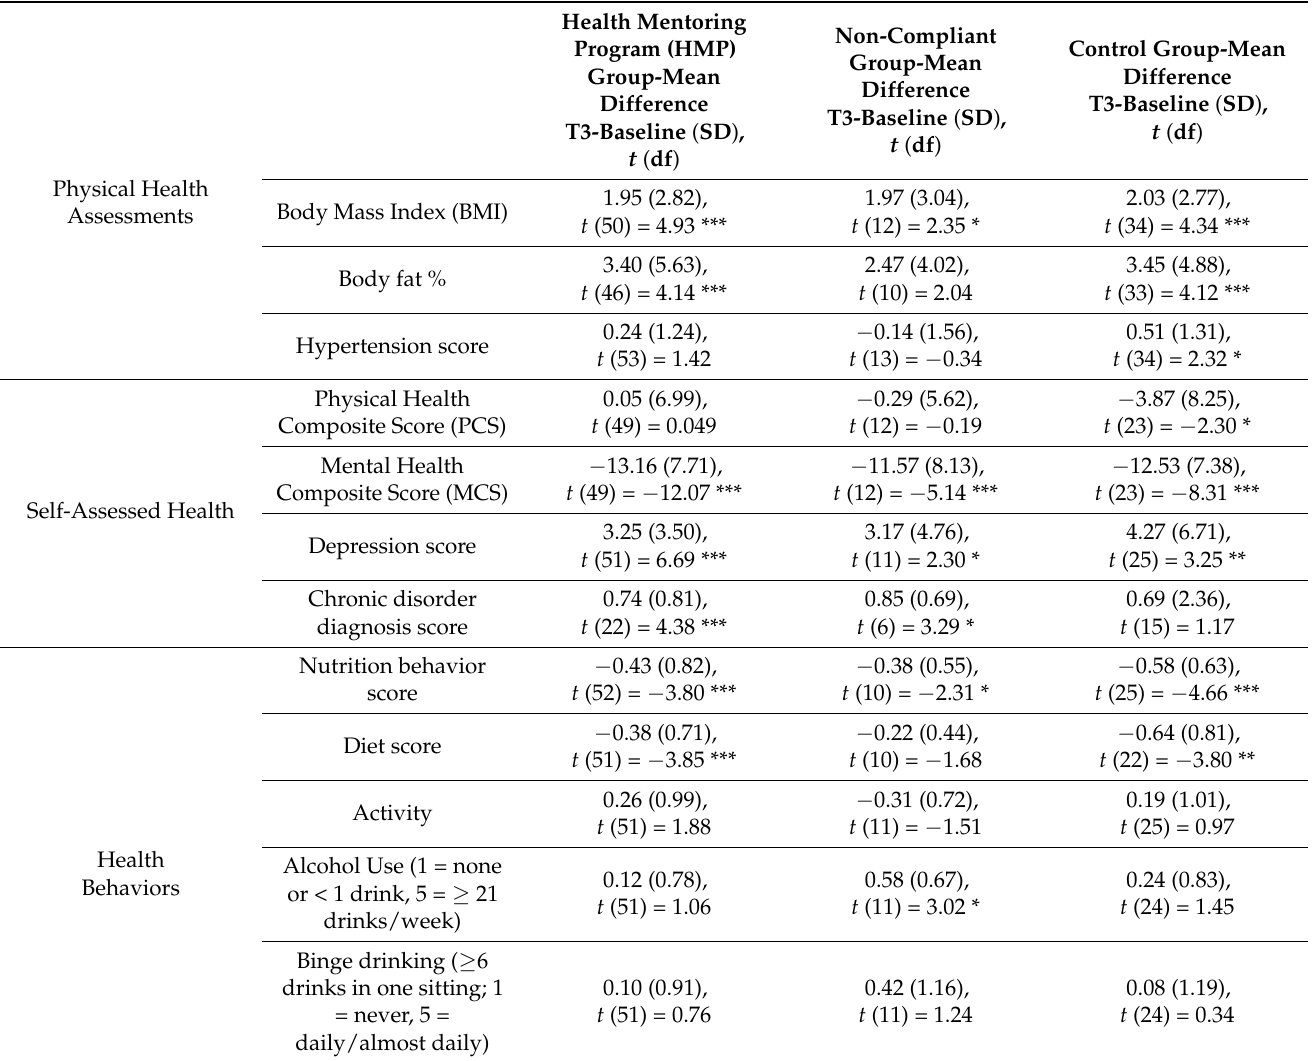
Table 4. Change in physical health assessments and self-assessed health outcome mean scores from baseline to T3 within each study